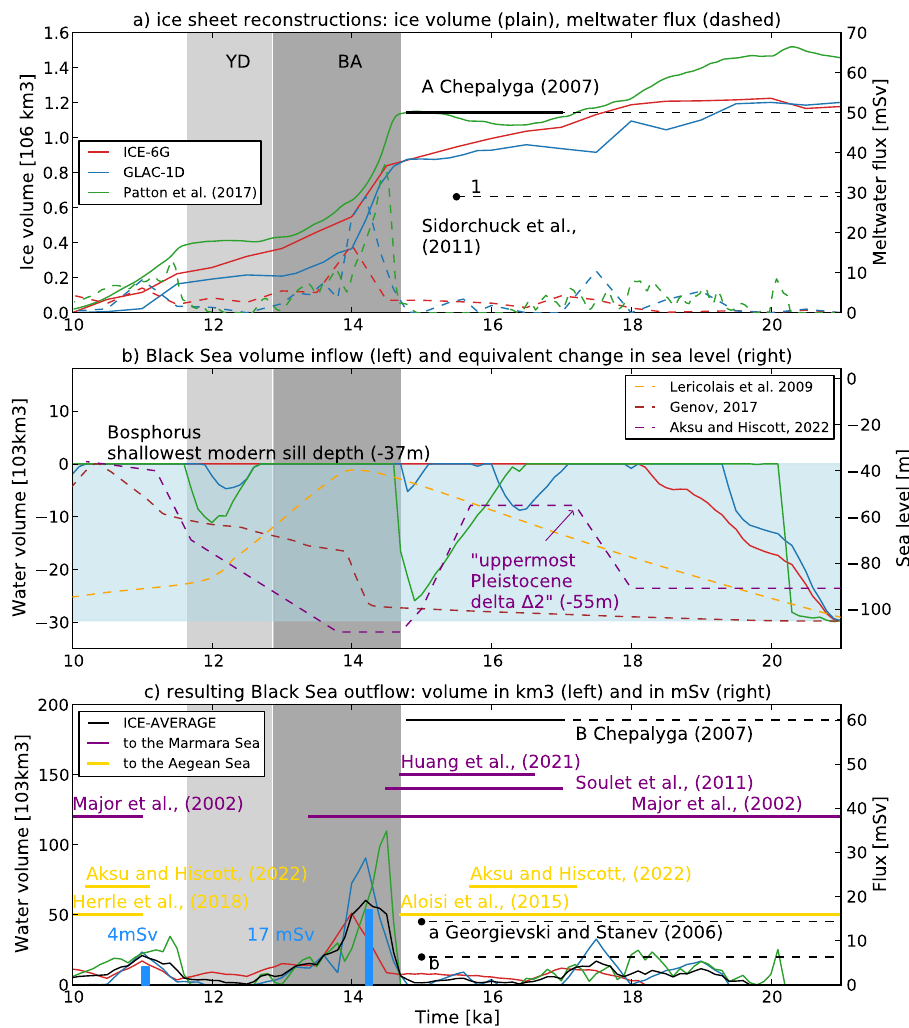
Figure 2. ( a ) Ice sheet reconstructions from three different sources with the volume of ice (plain curves, left axis) and associated meltwater flux (dashed curves, right axis) potentially draining to the Caspian Sea and Black Sea catchment. “A” 13 and “1” 12 represent meltwater-driven flux reconstructions from the Caspian Sea to the Black Sea. ( b ) Black Sea level (right axis, m, relative to modern sea level) and associated volume changes (left axis, km 3 ) deduced from the Black Sea’s water budget with FIS meltwater input as shown in panel a ), and the regional water flux P–E (precipitation-minus-evaporation) from two transient simulations of MIROC4m and Trace-21 ka. The water volume is expressed as the complementary volume needed to reach the Bosphorus sill at − 37 m, the level necessary for the Black Sea to outflow to the Mediterranean. The lowest BSL at the LGM is estimated to be – 105 m 29,30 and the total volume for outflowing to occur is 29,675 km 3 (light blue horizontal patch). Superimposed are BSL reconstructions by Lericolais et al. 29 , Genov 30 and Aksu and Hiscott 11 . The reconstruction by Aksu and Hiscott (2022) suggests a Black Sea outflowing from 17.2 to 15.7 ka over the uppermost “Pleistocene delta Δ2” (− 55 m) as inferred from seismic reflection. ( c ) Black Sea freshwater outflowing (red, blue, and green) over the Bosphorus sill, as a result of ( a ) and ( b ). The black plain line marked with “B” represents an estimation (in mSv) by Chepalyga 13 . Black dots (marked with “a” and “b”) represent other two estimations for 15 ka at the Bosphorus Strait 31 . The horizontal plain lines represent the chronology reported in previous studies for Black Sea outflowing to the Marmara Sea (purple) and the Aegean Sea (orange). Blue patches represent the scenarios of the present study carrying out hosing experiments with a regional oceanic model: “4mSvFIS” (12,614 km 3 of additional freshwater over 100 years) and “17mSvFIS” (53,611 km 3 over 100